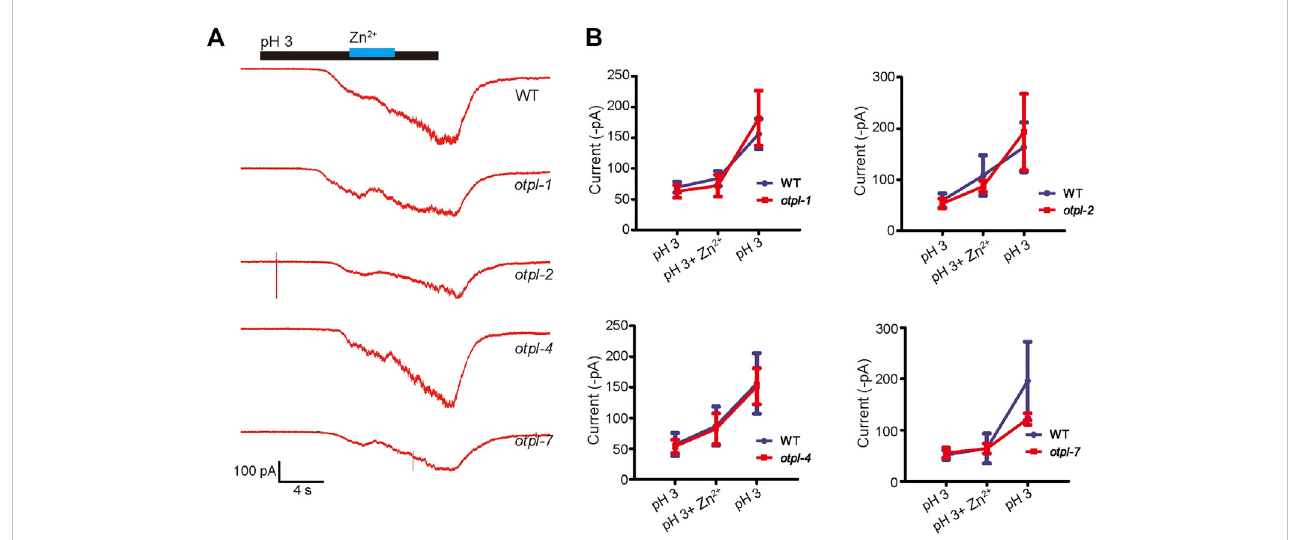
FIGURE 4 Single-gene otopetrin mutantsdonotaffect invivo acid-responsivecurrentsofASHneurons. (A) Invivo recordingofASHneuronsin C.elegans ,acid-sensing currents were not blocked by 1 mM Zn 2+ . The cation in solution is NMDG + . Gravity perfusion system was used to deliver acid stimulation, switching channels to replace the solution. Membrane potential was clamped at − 60 mV. (B) Statistical values of the current. The membrane potential was clamped at − 60